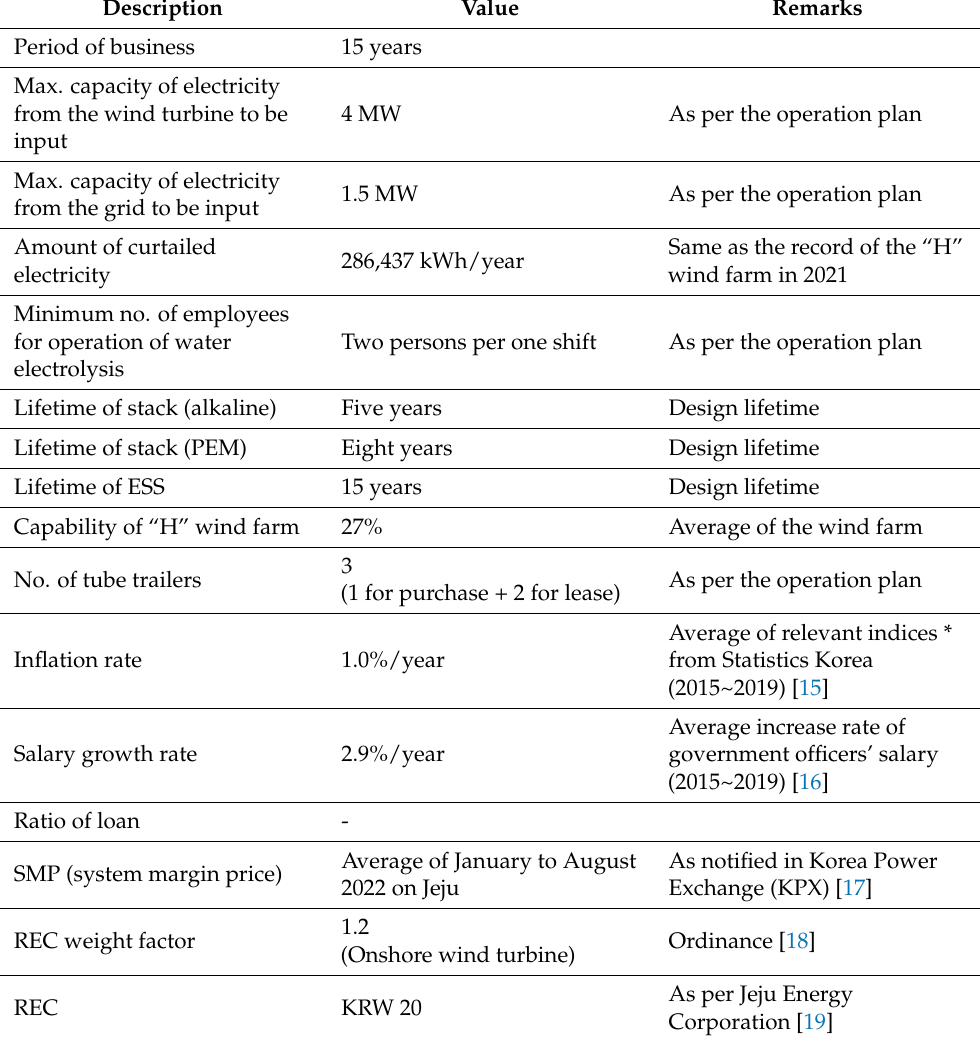
Table 4. Premise subject to project execution for calculating hydrogen